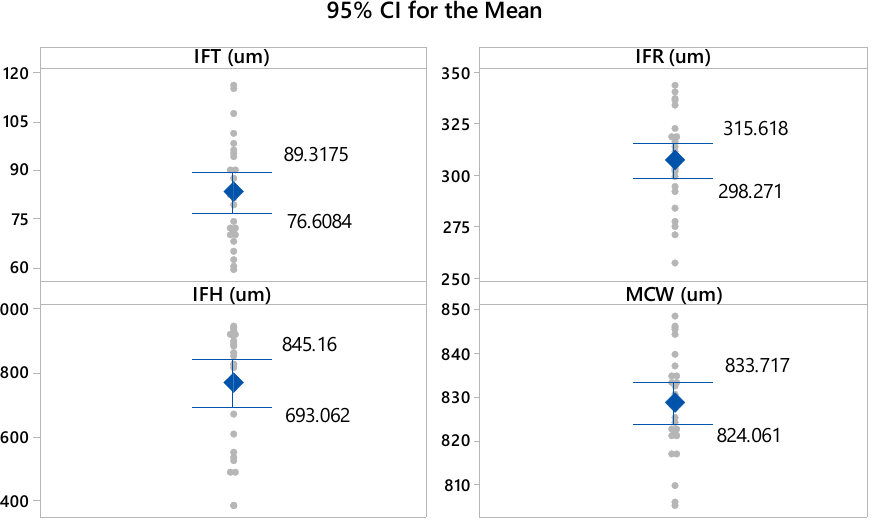
Figure 4. Interval plots for means of responses drawn at 95% confidence interval (CI).